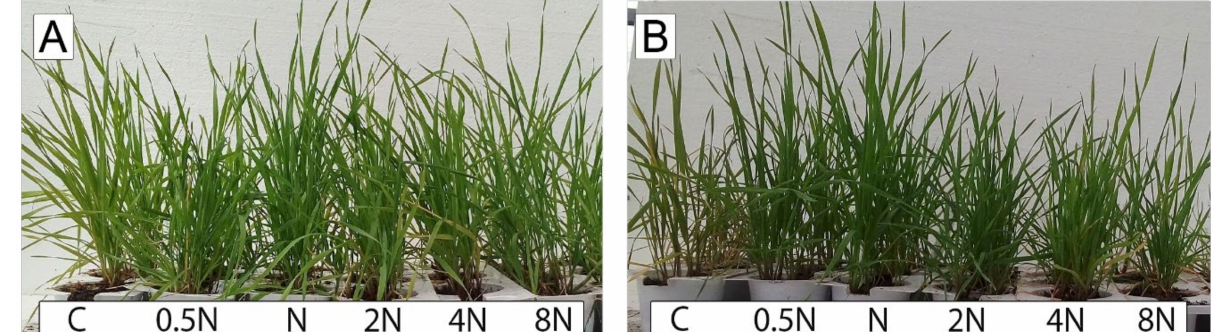
Figure 3. A. myosuroides population AMIV seedlings sprayed with fenoxaprop-P-ethyl ( A ) and pinoxaden ( B ) at doses of 0.5 N, N, 2 N, 4 N and 8 N. C: untreated control.